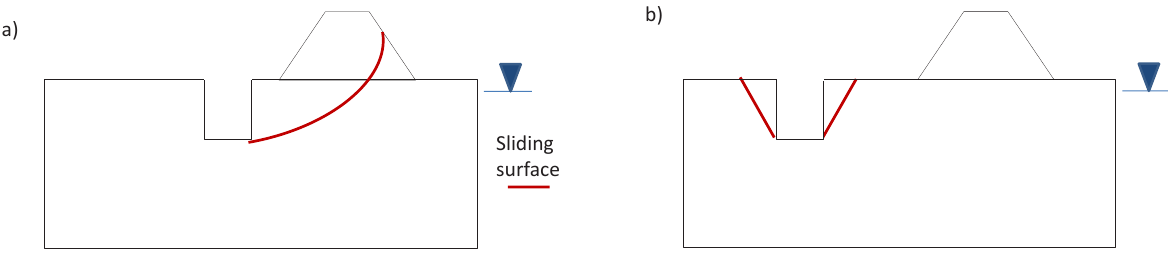
Figure 1: Interaction between embankment and excavation from the slope stability point of view: (a) excavation “close” to the embankment – interaction possible even not during the flood and (b) excavation “far” from the embankment – no interaction.